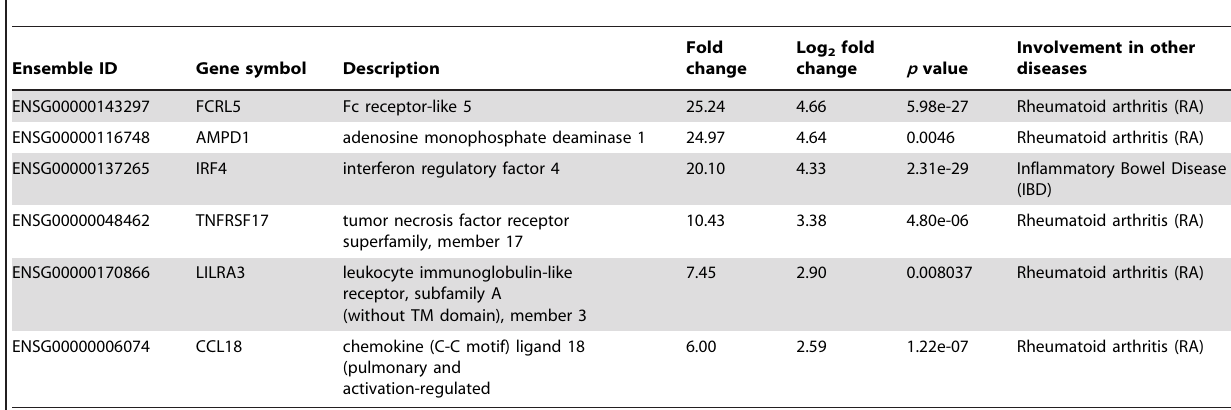
Table 5. Selected upregulated genes identified in periodontitis and involved in other chronic inflammatory diseases.